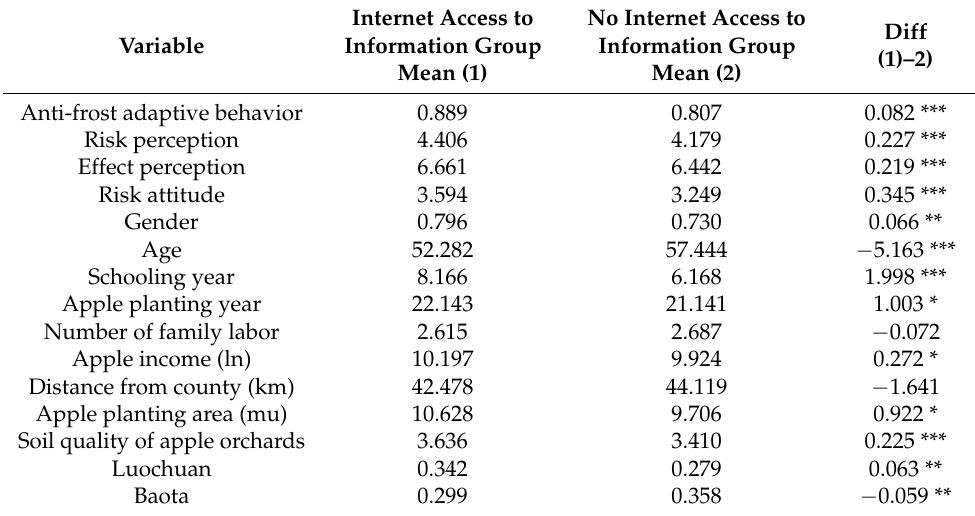
Table 3. Grouping descriptive